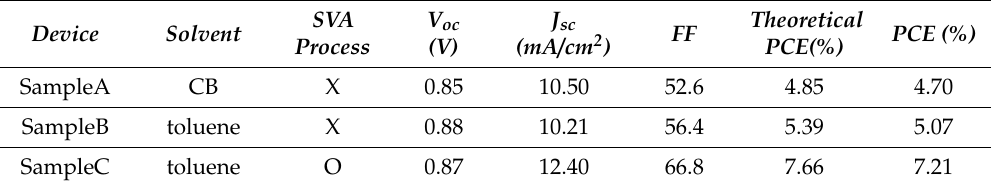
Table 1. Device performance of inverted SMPV1:PC 71 BM solar cells with various solvents and treatment conditions.